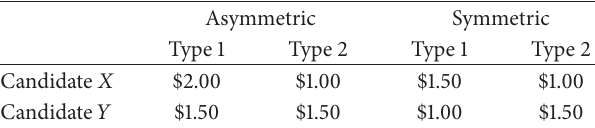
Table 3: Symmetric and asymmetric payoffs. Table 4: (a) Predicted turnout probabilities and cost cutpoints